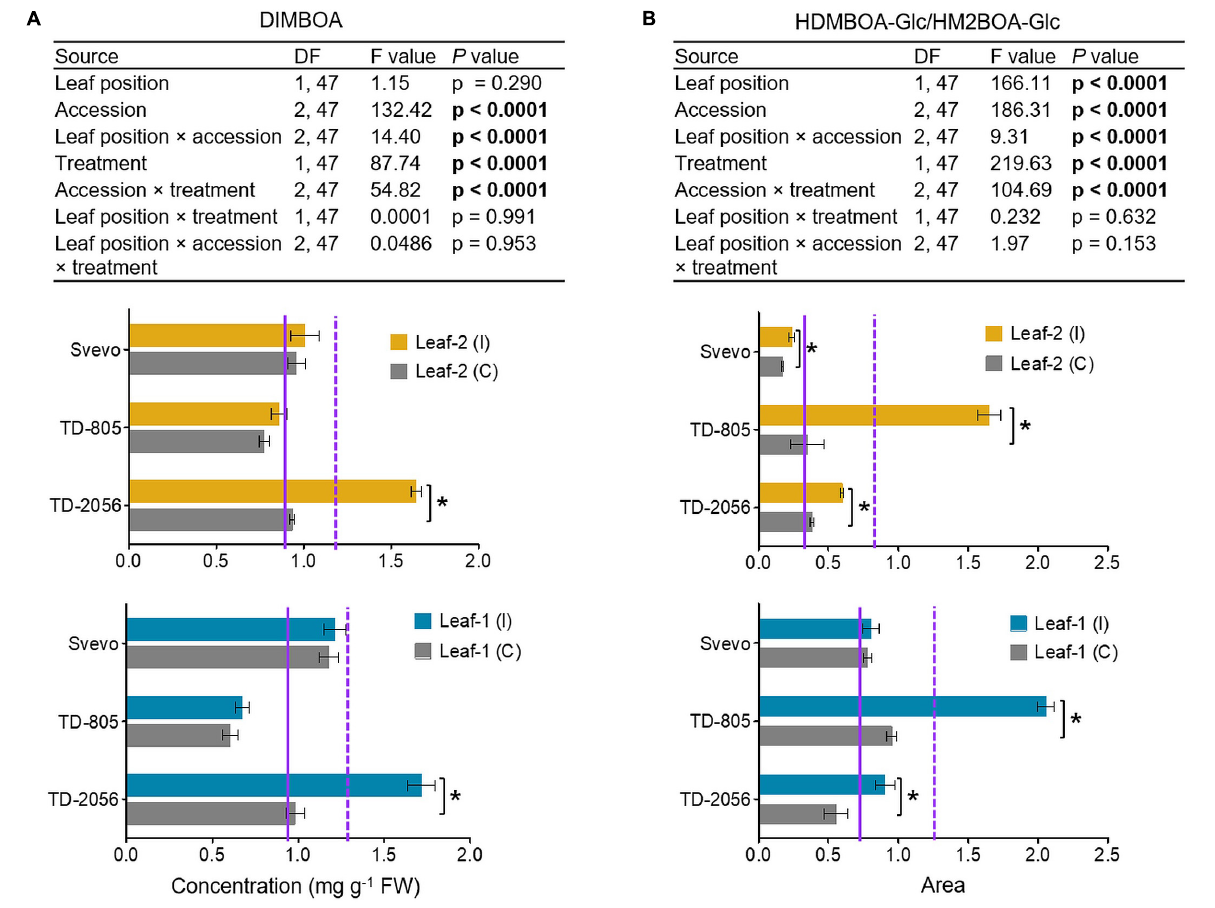
FIGURE 5 | Quantification of chemical defensive metabolites in the phloem sap. (A) DIMBOA concentration (mg per g FW) and (B) HDMBOA-Glc/HM2BOA-Glc content (peak area) were evaluated in the phloem sap obtained from leaf-1 and leaf-2 in both untreated controls (C) and 96 h following infestation (I) with R. padi using the choice whole cage bioassay. Values are expressed as mean ± SE ( n = 4). The solid and dashed purple lines represent the mean value for each individual leaf type under control and infested conditions among the accessions, respectively. The effects of leaf position, accession, treatment, and their interaction (leaf position × accession × treatment) were tested by two-way ANOVA analyses. The asterisk represents the significant difference between treatments in a particular accession analyzed by Student’s t -tests ( p < 0.05). In bold are the parameters that were significantly affected, p <